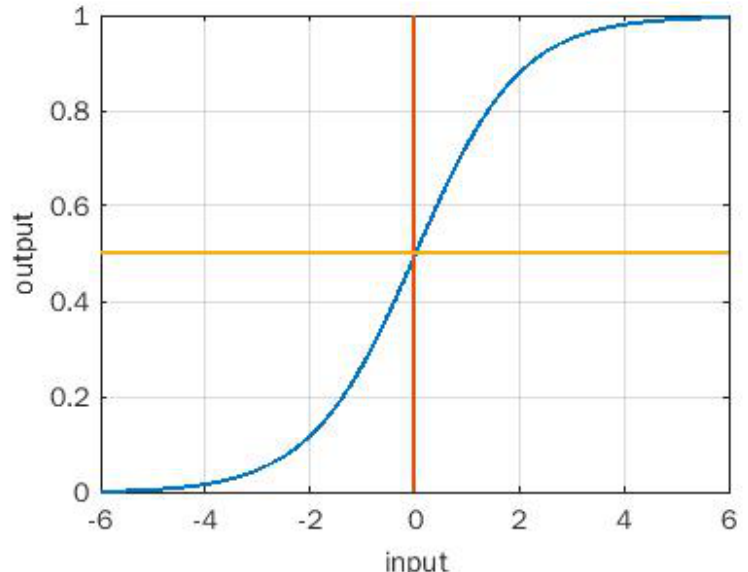
Figure 6. Sigmoid